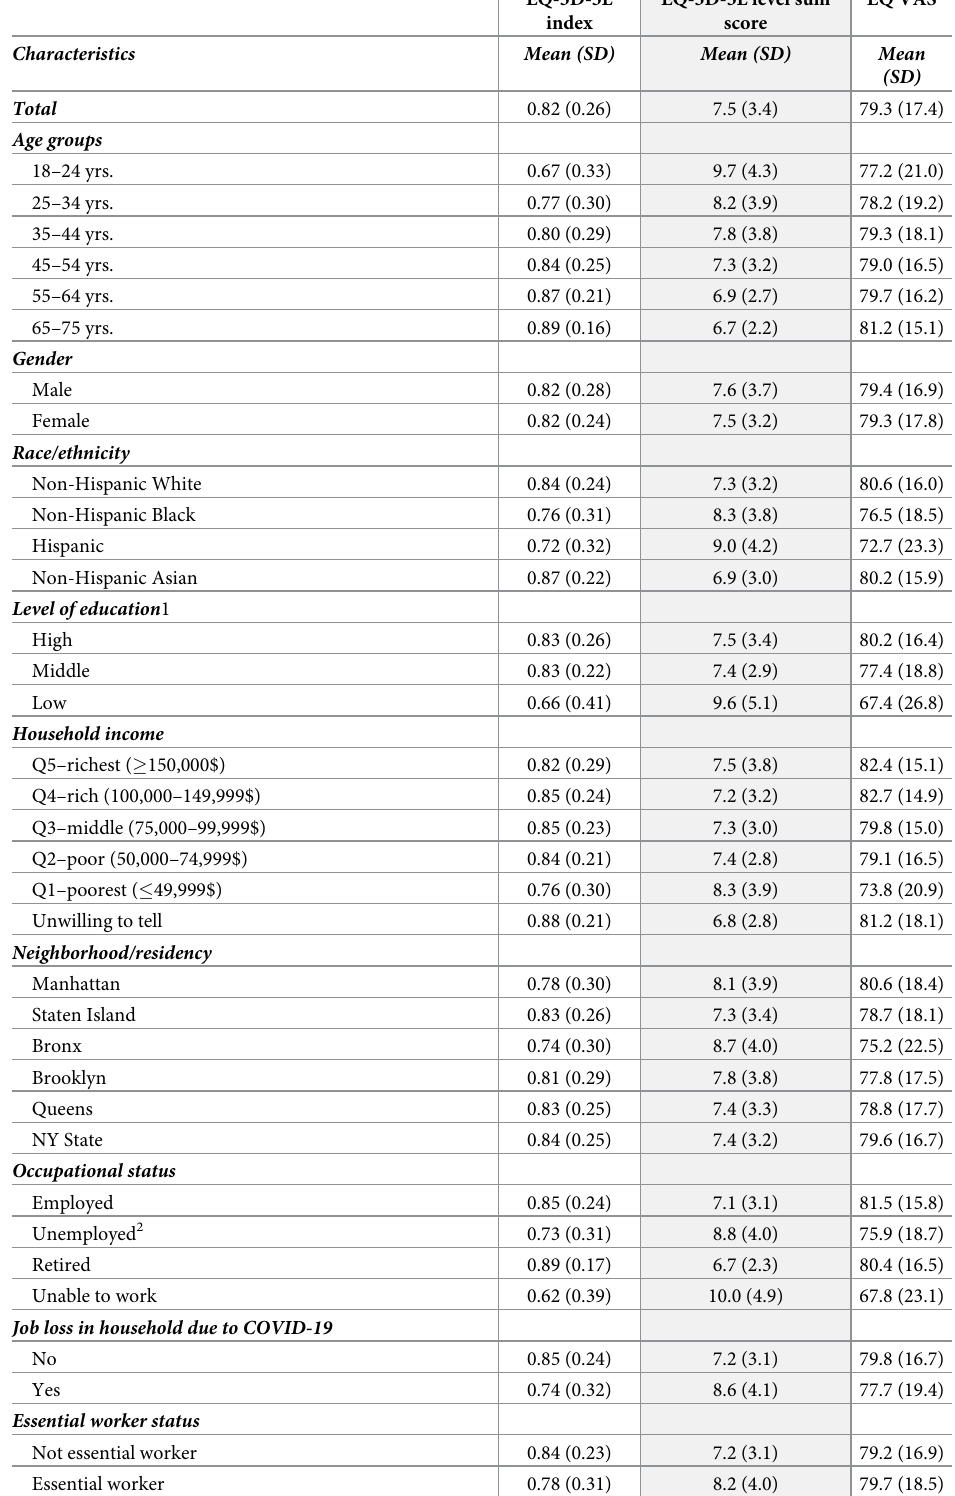
Table 2. Mean (SD) EQ-5D-5L index, level sum score, and EQ VAS scores by respondent’s